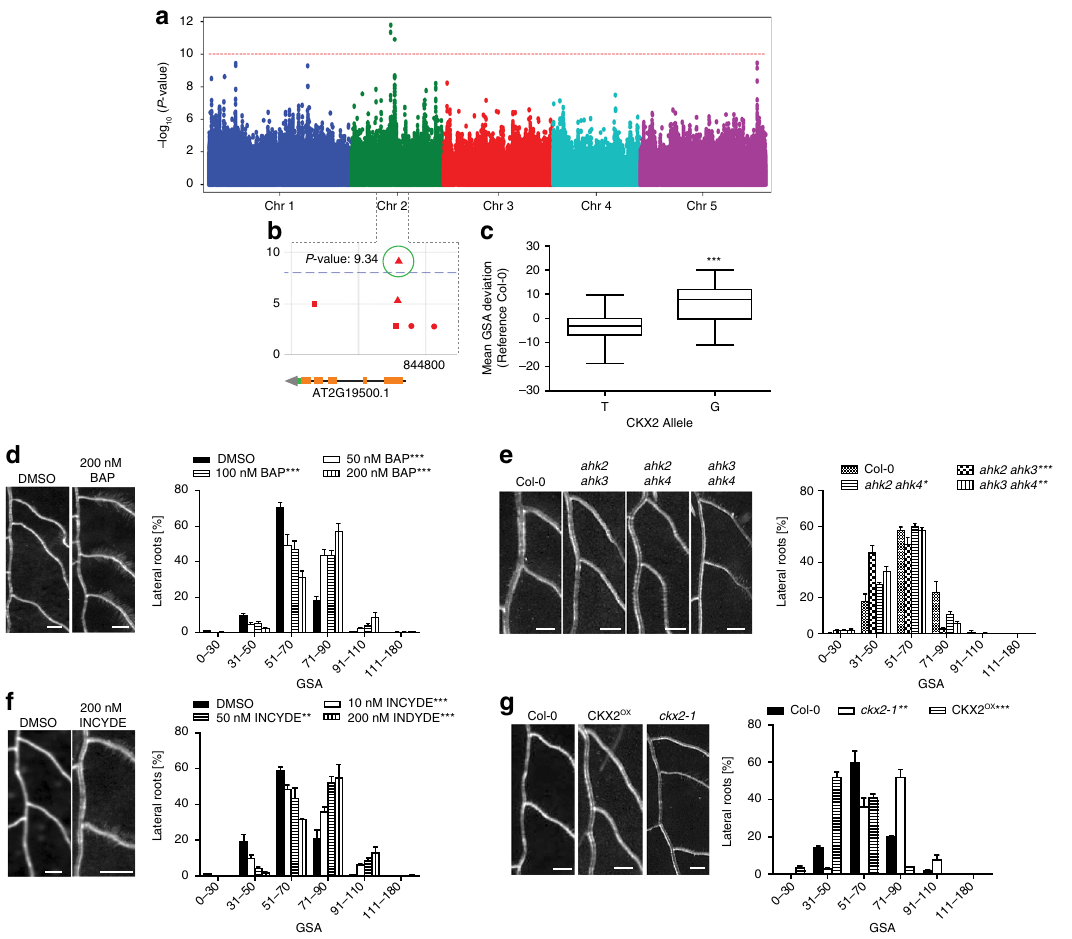
Fig. 2 Genome-wide association study (GWAS) on gravitropic set point angle (GSA). a Manhattan plot of GWAS results. The dotted horizontal line indicates a signi fi cance level of 0.1 after Bonferroni correction for multiple testing. b Magni fi cation of the peak region on chromosome 2. A highly signi fi cant SNP was located at position 8,447,233 in the coding region of CKX2 . c Mean GSA of T and G alleles of CKX2. Horizontal lines show the medians; box limits indicate the 25th and 75th percentiles; whiskers extend to the min and max values. Student ’ s t -test P -value: *** P < 0.001. d – g Representative images and GSA distributions of untreated and 6-Benzylaminopurin (BAP)-treated Col-0 wild type d , Col-0 wild type , ahk2 ahk3 , ahk2 ahk4 and ahk3 ahk4 e , untreated and INCYDE-treated Col-0 wild type f , Col-0 wild type, ckx2-1 and CKX2 OX seedlings g . Kolmogorov – Smirnov test P -values: * P < 0.05, ** P < 0.01, *** P < 0.001 (compared to DMSO solvent or Col-0 wild type control). Mean± SEM, n = 5 plates (16 seedlings with 65 – 160 LRs per plate). Scale bars, 2 mm. d – g Experiments were repeated at least three